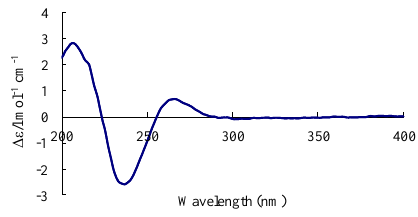
Figure 3. Circular dichroism (CD) spectrum of compound 2 .